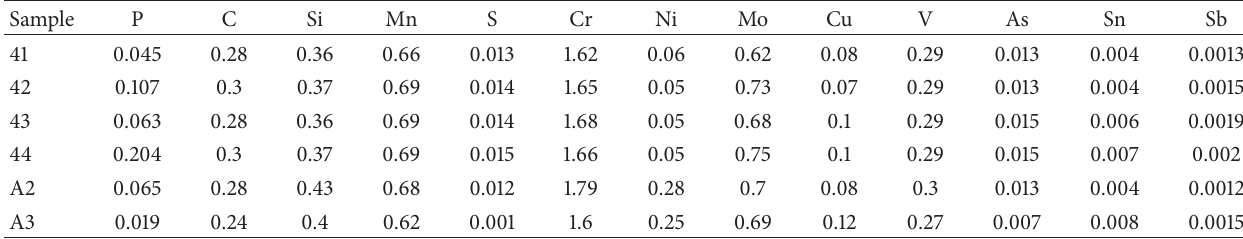
Table 1: Chemical composition of 30Cr2MoV rotor steel (wt%).